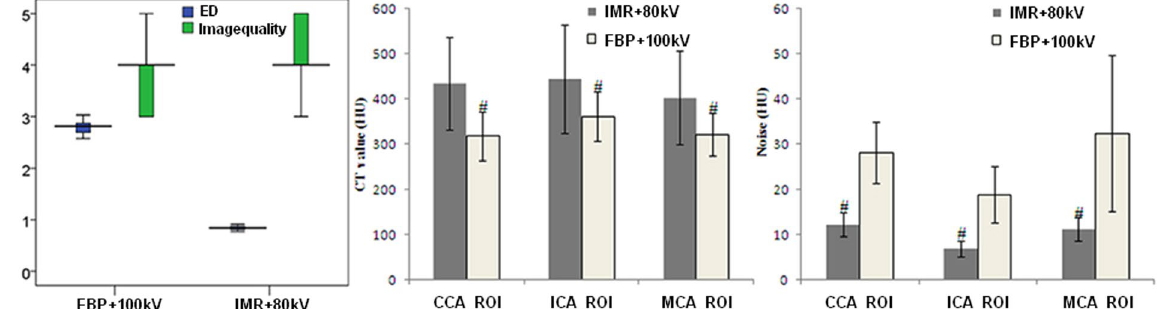
Figure 1. Boxplot and bar charts to visually show the improvements of the IMR algorithm versus FBP algorithm. Boxplot a show the mean ED and image quality of the IMR group versus the FBP group. Compare to FBP + 100 kV algorithm, patients received IMR + 80 kV algorithm have less radiation dose, with improvement in image quality, simultaneously. The middle chart and the right chart show the mean CT values and mean image noise in the ROIs of both groups. The CT values of the ROIs of the FBP group were significantly lower than those of the IMR group ( # p < 0.01), whereas the image noises were significantly lower in the IMR groups than those in the group FBP ( # p < 0.01). Error bars represent 95% confidence intervals median value and the upper and lower bars represent the first and third quartiles respectively, whiskers represent the 95% confidence interval. Abbreviations: ED, effective dose; FBP, filtered back projection; IMR, iterative model construction; ROI, region of interest; CCA, common carotid artery; ICA, internal carotid artery; MCA, middle cerebral artery.